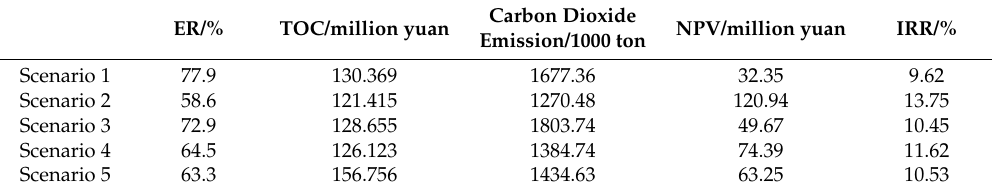
Table 4. Annual ER, TOC, CE, NPV, and IRR for different optimization